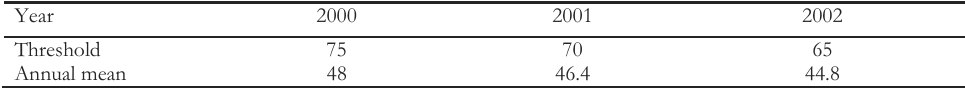
levels ( (cid:80) g/m 3 10